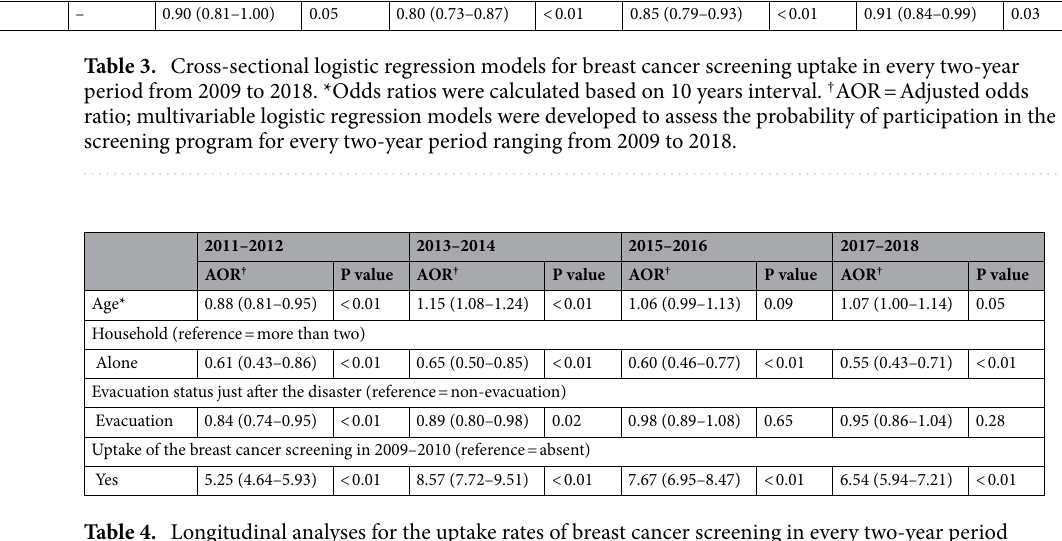
Table 4. Longitudinal analyses for the uptake rates of breast cancer screening in every two-year period from 2011 to 2018. *Odds ratios were calculated based on 10 years interval. † AOR = Adjusted odds ratio; multivariable logistic regression models were formulated to determine the likelihood of participation in the screening program for each biennial period spanning from 2011 to 2018. The data pertaining to evacuation statuses were procured from 2011, whereas the other explanatory variables used in the models were sourced from 2009 to